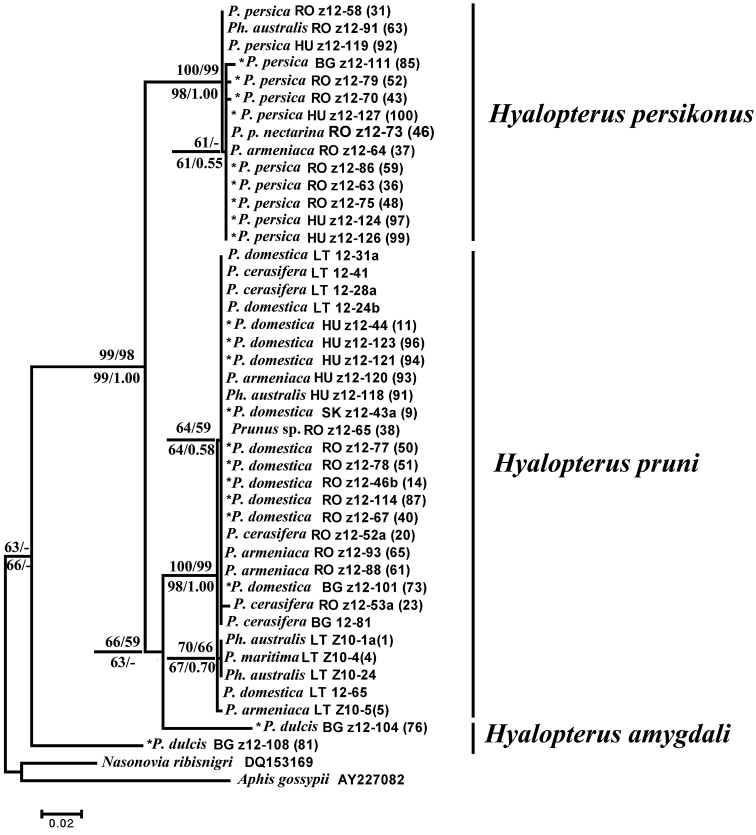
Maximum likelihood (ML) tree showing phylogenetic relationships among three Hyalopterus species based on partial sequences of mitochondrial COI (564 positions in final set). Numbers above branches indicate support of NJ (left) and MP (right) bootstrap test with 1000 replicates, and numbers below branches indicate support of ML (left) bootstrap test with 1000 replicates and posterior probabilities of BI analysis (right). Samples used for the discriminant analysis with a priori specified group membership followed by the construction of identification key are asterisked (*). The remaining samples were used for the post hoc classification. Sample numbers are the same as given in Table 1, together with the abbreviated symbol of respective country: BG Bulgaria, HU Hungary, LT Lithuania, RO Romania, SK Slovakia.